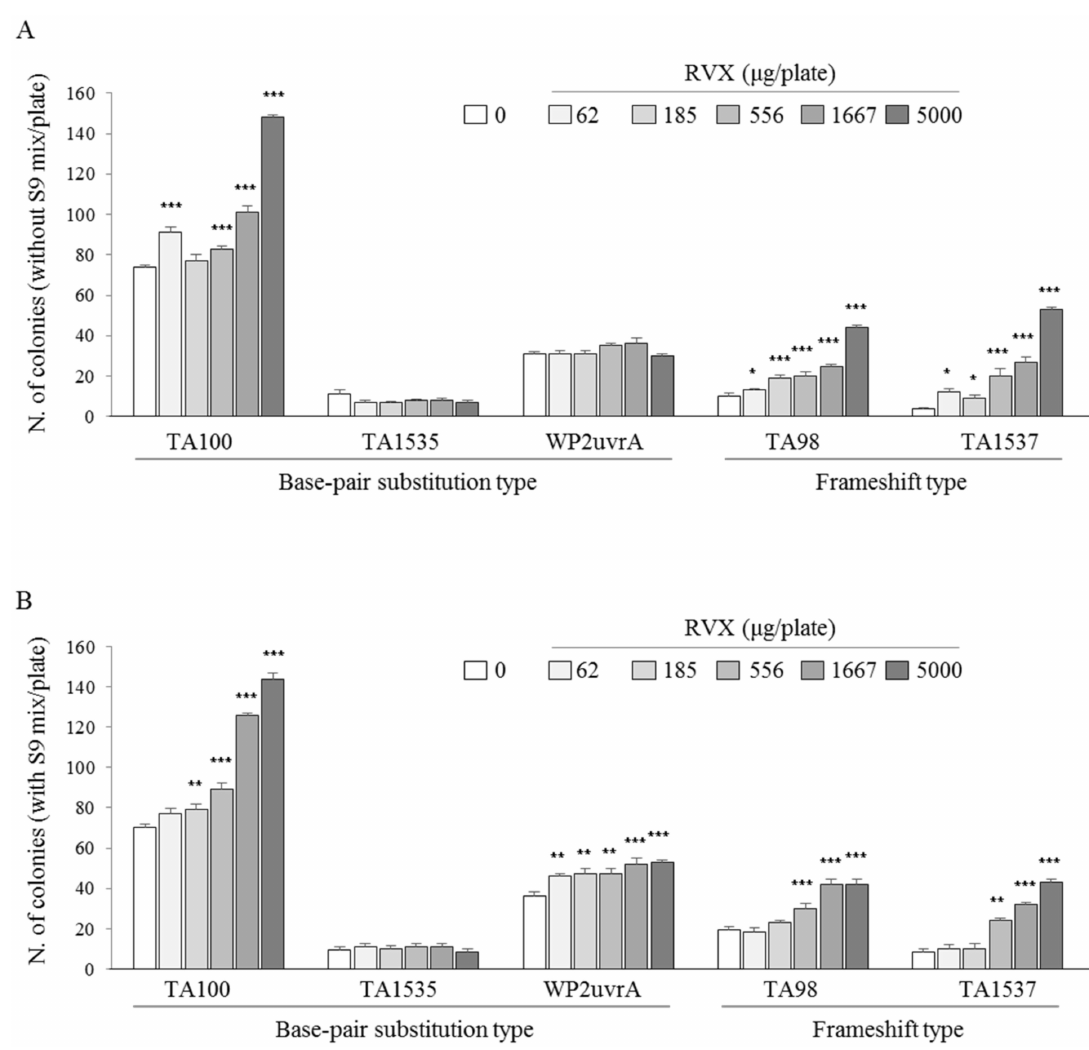
Figure 2. Bacterial reverse mutation test was performed according to the Organization for Economic Co-operation and Development (OECD) guideline number 471. The RVX or positive control was treated for each bacterial strain under the conditions of the S9 mix: ( A ) absence or ( B ) presence of the mix after incubation. The revertant colonies were counted, and the above test was repeated in triplicate. * p < 0.05, ** p < 0.01 and *** p < 0.001 compared to the negative control (0 µ